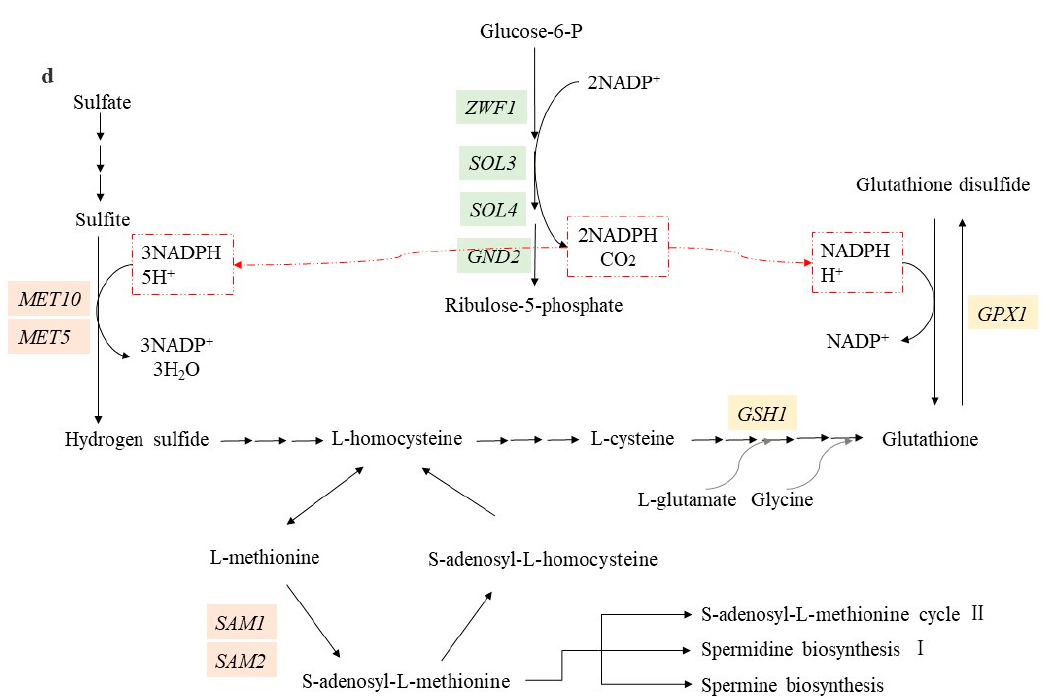
Figure 5. ( a ) Pentose phosphate pathway (oxidative phase), ( b ) glutathione metabolism, ( c ) AdoMet synthesis, and ( d ) a combination of ABC. The green color indicates the genes that are related to the oxidative phase in the pentose phosphate pathway, the red color indicates the genes that are related to AdoMet synthesis, and the yellow color indicates the genes that are related to glutathione metabolism.